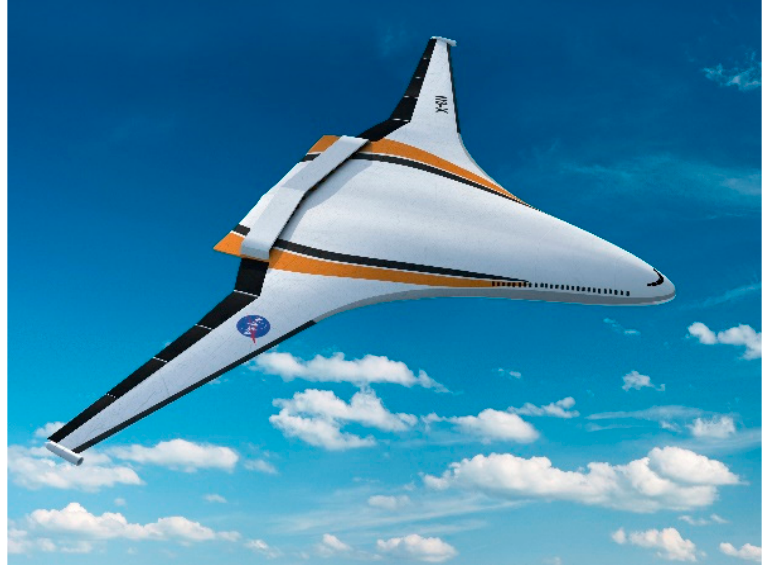
Figure 2. NASA’s N3-X, Turboelectric blended wing body concept.